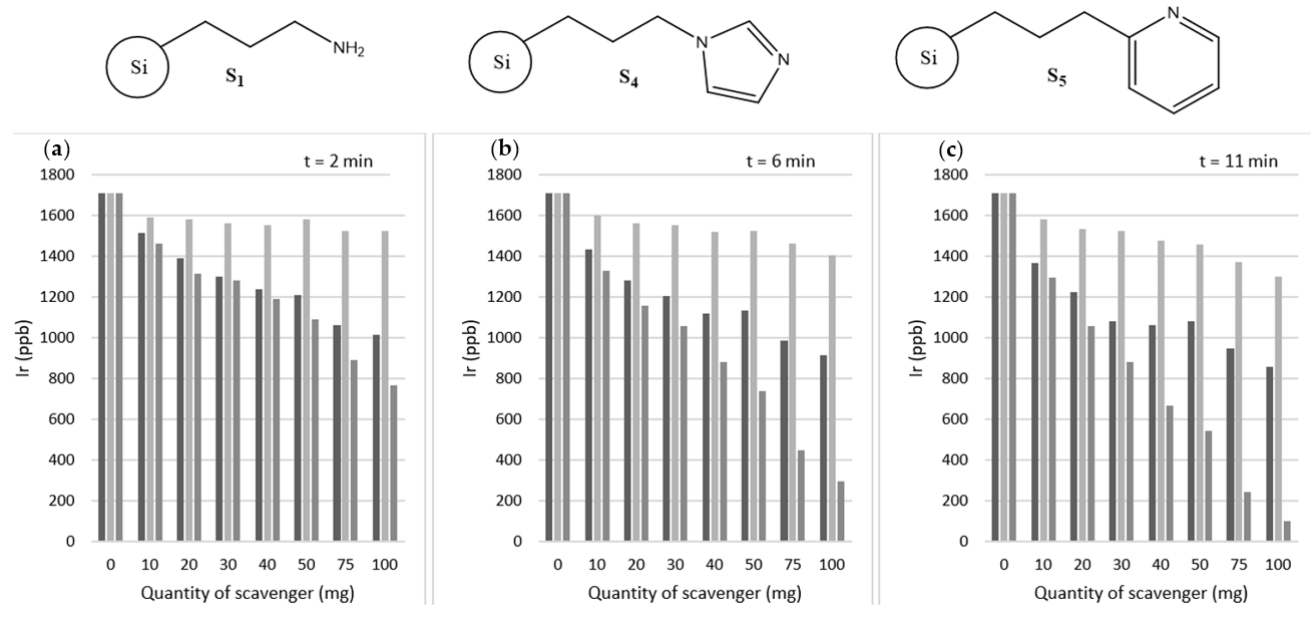
Figure 4. Amount of iridium present in samples following the addition of a variable amount of each scavenger ( S 1 left column, S 4 middle column, S 5 right column) after ( a ) t = 2 min, ( b ) 6 min, and ( c ) 11 min exposure time ( N = 1).